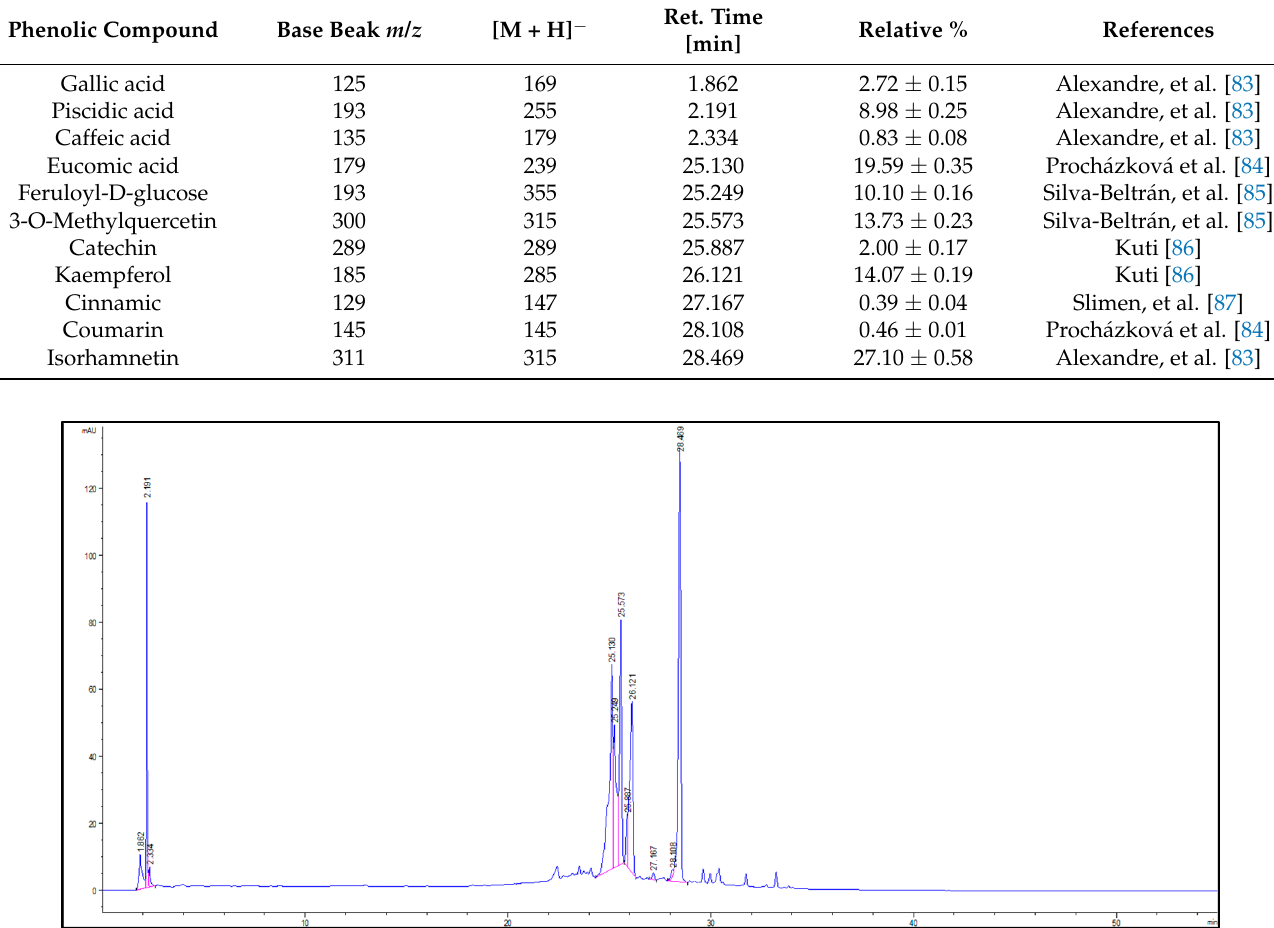
Figure 2. LC-Chromatogram of polyphenolic compounds in ethanolic extract of prickly pear peel. Table 5. LC-Tandem MS of polyphenolic compounds of prickly pear peel, in negative mode (EI)-MS.